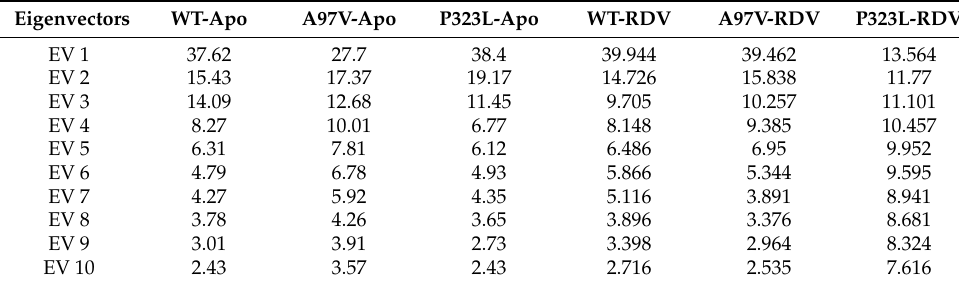
Figure 6. The covariance matrix constructed from the whole MD trajectory fraction of motion of the first 10 eigenvectors plotted against the corresponding eigenvector. The first 10 eigenmodes were used to calculate the percentage fraction of motion of each eigenvector for RdRp-apo ( A ) and RdRp-RDV ( C ), and the fraction of motions by a single eigenvector for RdRp-apo ( B ) and RdRp-RDV complex ( D ). Table 2. Tabulated individual eigonvector